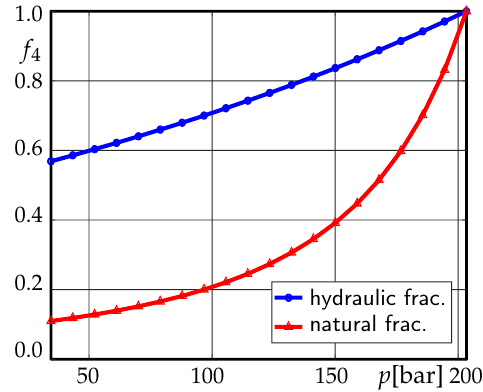
Figure 8. Permeability correction factor f 4 for hydraulic fractures and natural fractures with pressure p 0 = 34.5 MPa, σ h,min = 29 MPa, and σ h,max = 34